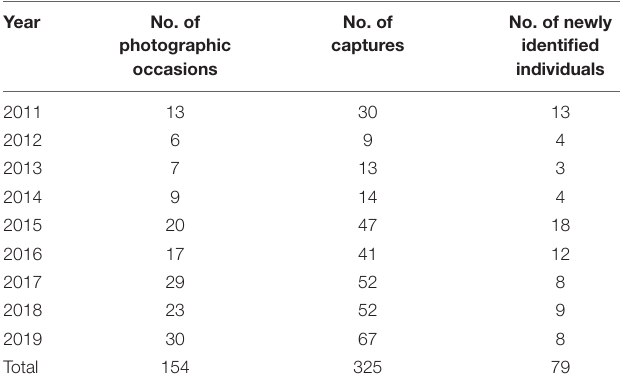
TABLE 1 | Summary of the photographic data used in the analysis, i.e., truncated to distinctive animals and good quality pictures. No. of